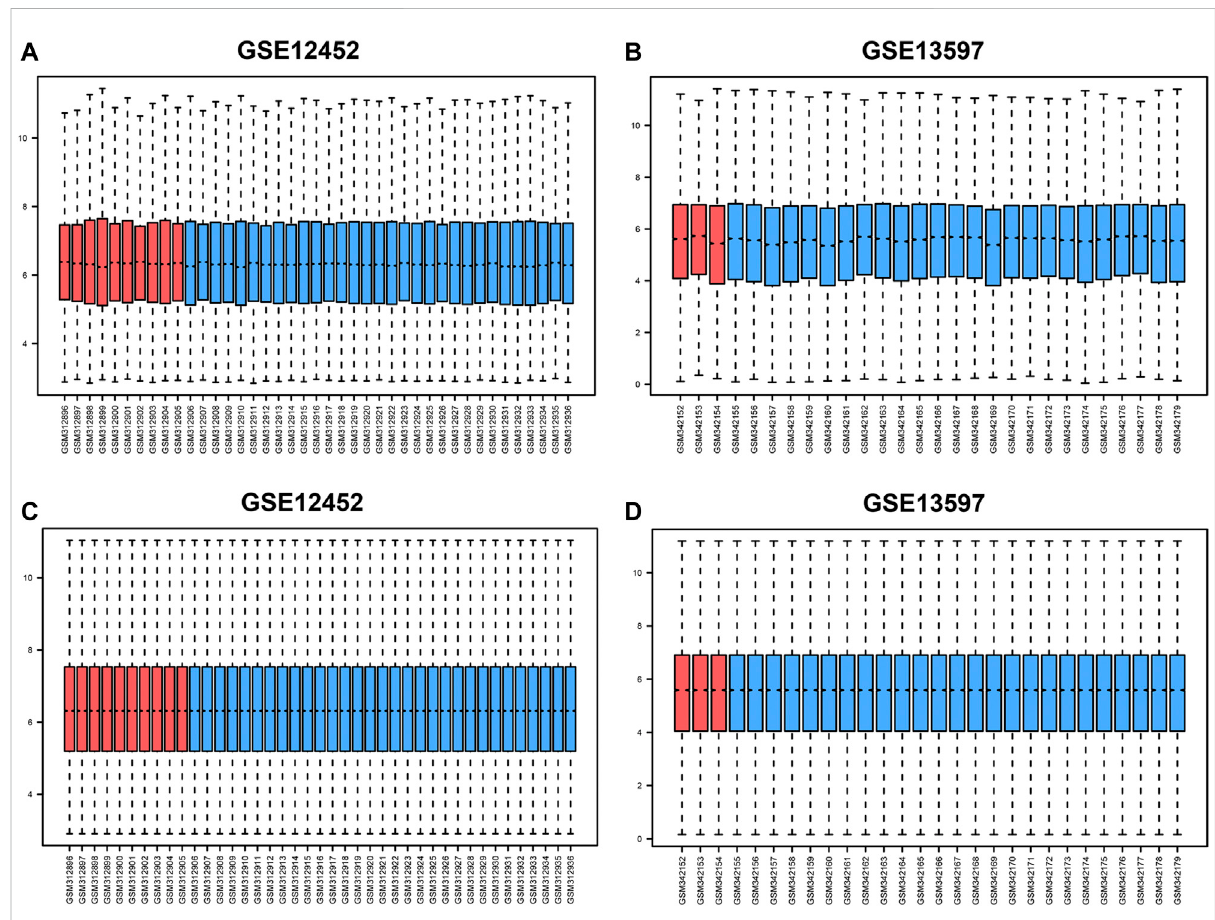
FIGURE 1 Box diagram before and after standardization of GSE12452 and GSE13597 datasets. (A – B) Box diagrams before standardization of GSE12452andGSE13597; (C – D) .BoxdiagramsafterstandardizationofGSE12452andGSE13597.Bluerepresentstumorsamples,andredrepresents normal samples. NPC, nasopharyngeal carcinoma; GEO, Gene Expression